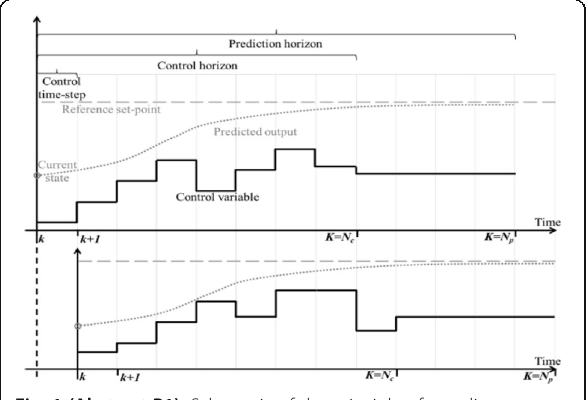
Fig. 1 (Abstract P1). Schematic of the principle of receding horizon [4].